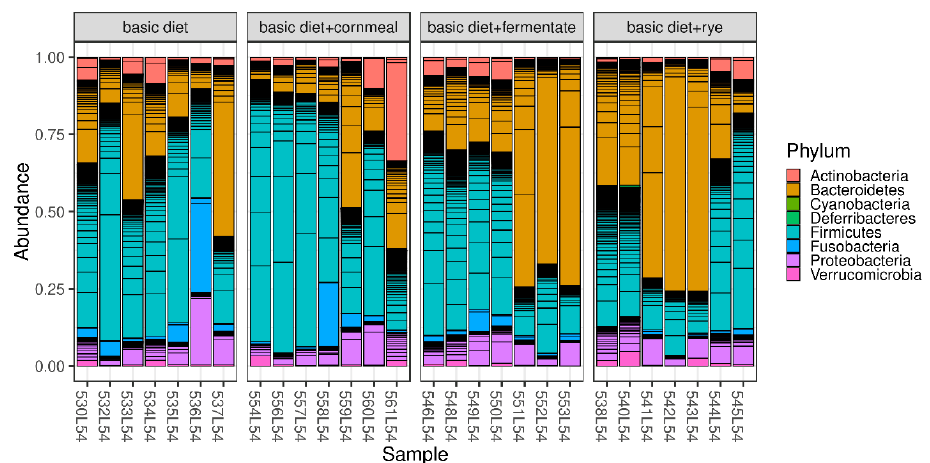
Figure 3. Bar charts represent the relative abundance of bacterial phyla determined using 16S rRNA gene sequencing in faecal samples of dogs offered different diets (vegetarian diet (basic diet) and the vegetarian diet supplemented with feather meal as well as either cornmeal (basic diet + cornmeal), fermented rye (basic diet + fermentate) or rye (basic diet + rye)). Microorganisms 2020 , 8 , x FOR PEER REVIEW Multiple testing on normalized counts on each phylum and family yielded no significant